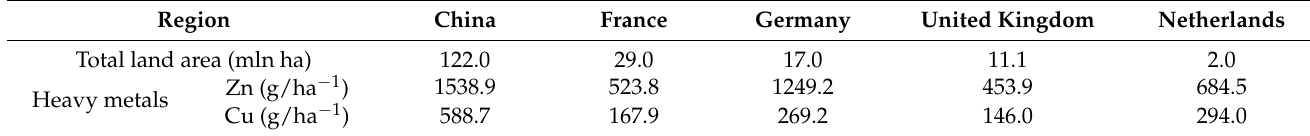
Table 3. Annual input of Zn and Cu in soil for 1 mln of ha